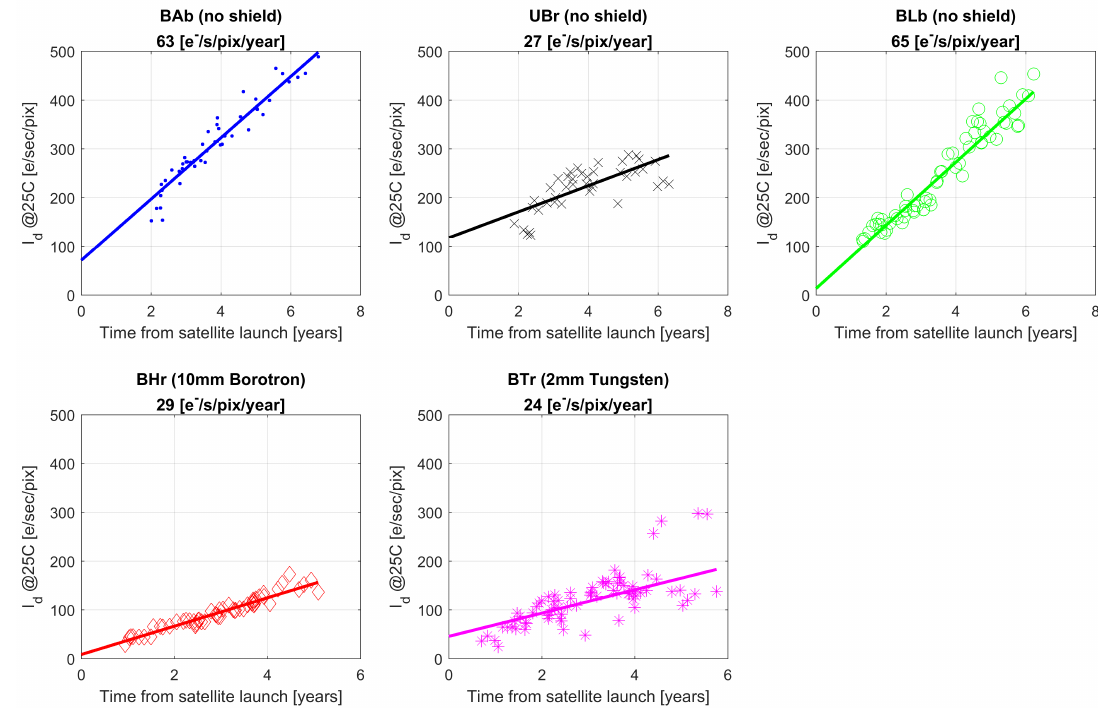
Figure 8. Evolution of the average dark current seen in BRITE satellites. The lines represent robust linear fit to data of individual